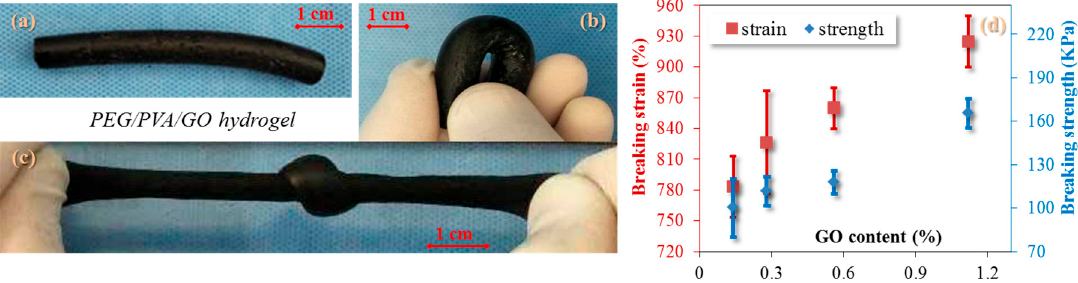
Figure 4. Mechanical analysis of conductive PVA/PEG/GO hydrogel in ( a ) the original state; ( b ) the bending state; ( c ) the knot-stretching state; and ( d ) the relationship of breaking strain and stretching with the increase of GO content.